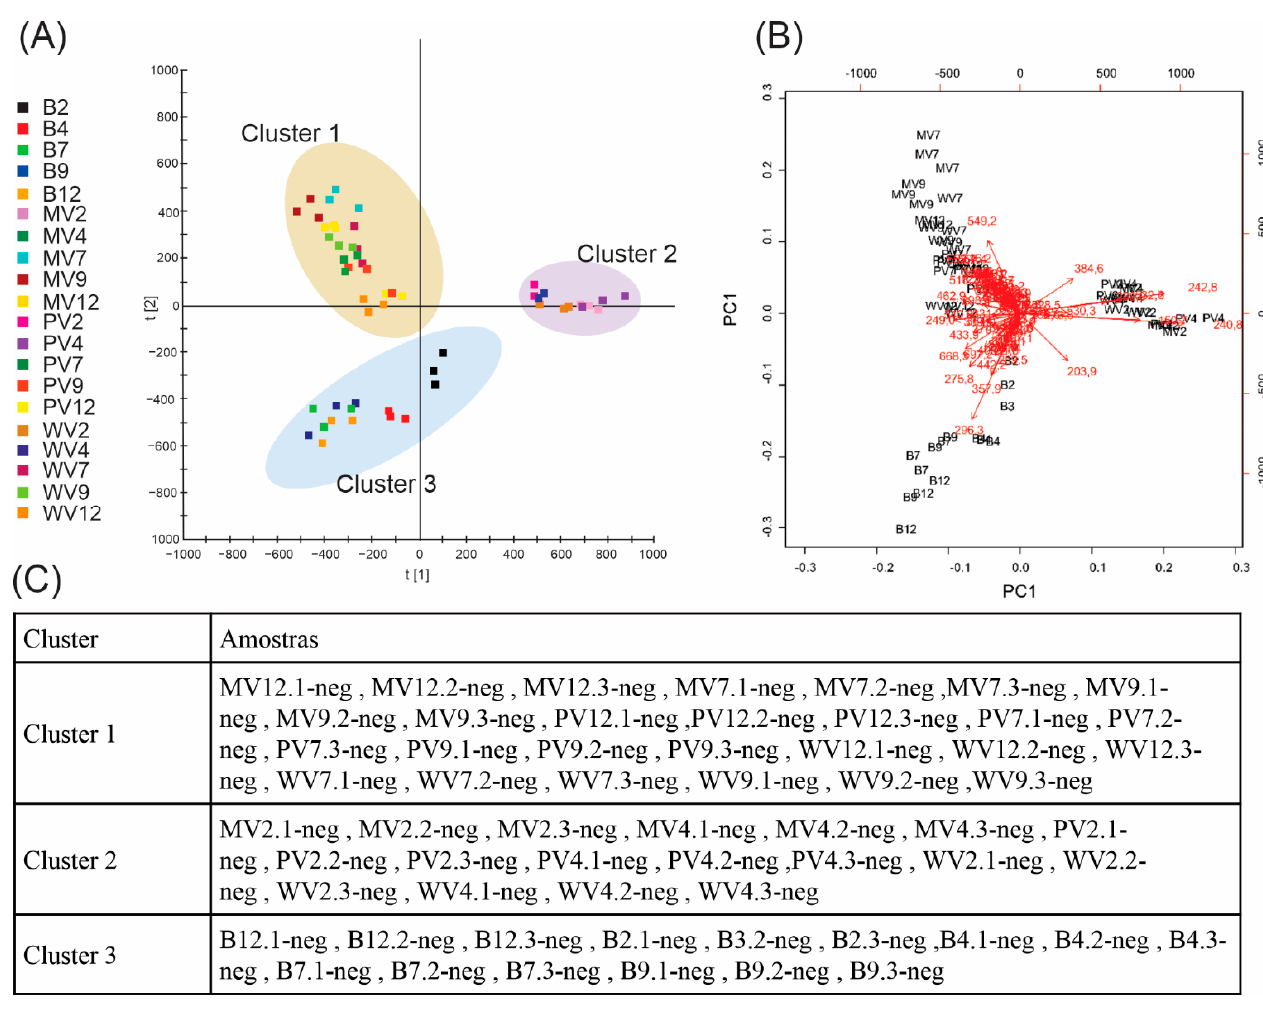
Figure 3. Unsupervised analyses of data acquired in negative mode: (A) Principal components analyses (PCAs)—symbols within the delimited transparent areas are those that form clusters defined by k-means. (B) Bi-plot analysis (scores × loadings). (C) K-means clusters.